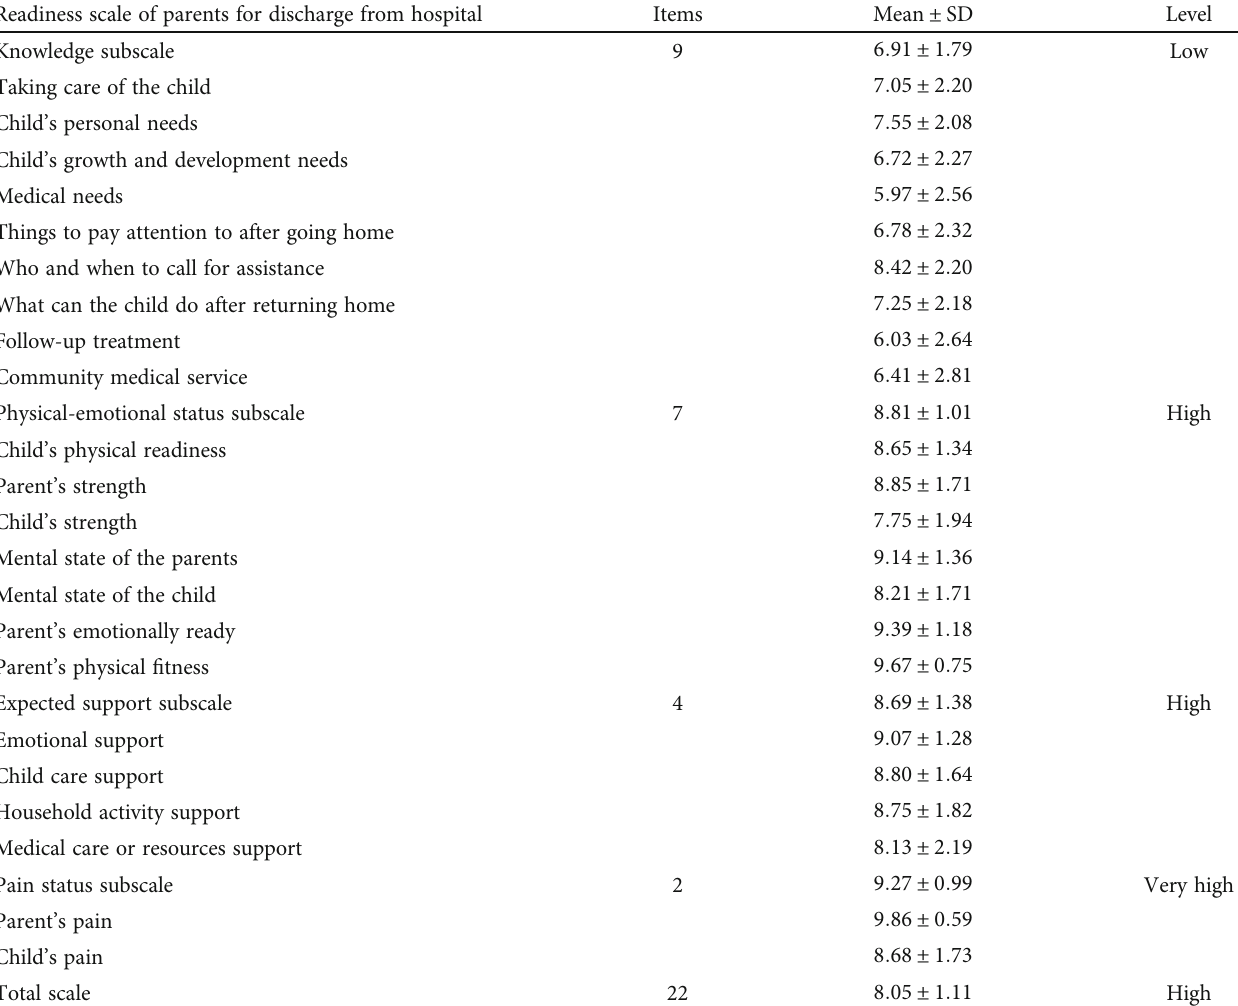
Table 2: Perception level of premature infants ’ parents towards the readiness for discharge from the hospital ( N = 208 ). Readiness scale of parents for discharge from